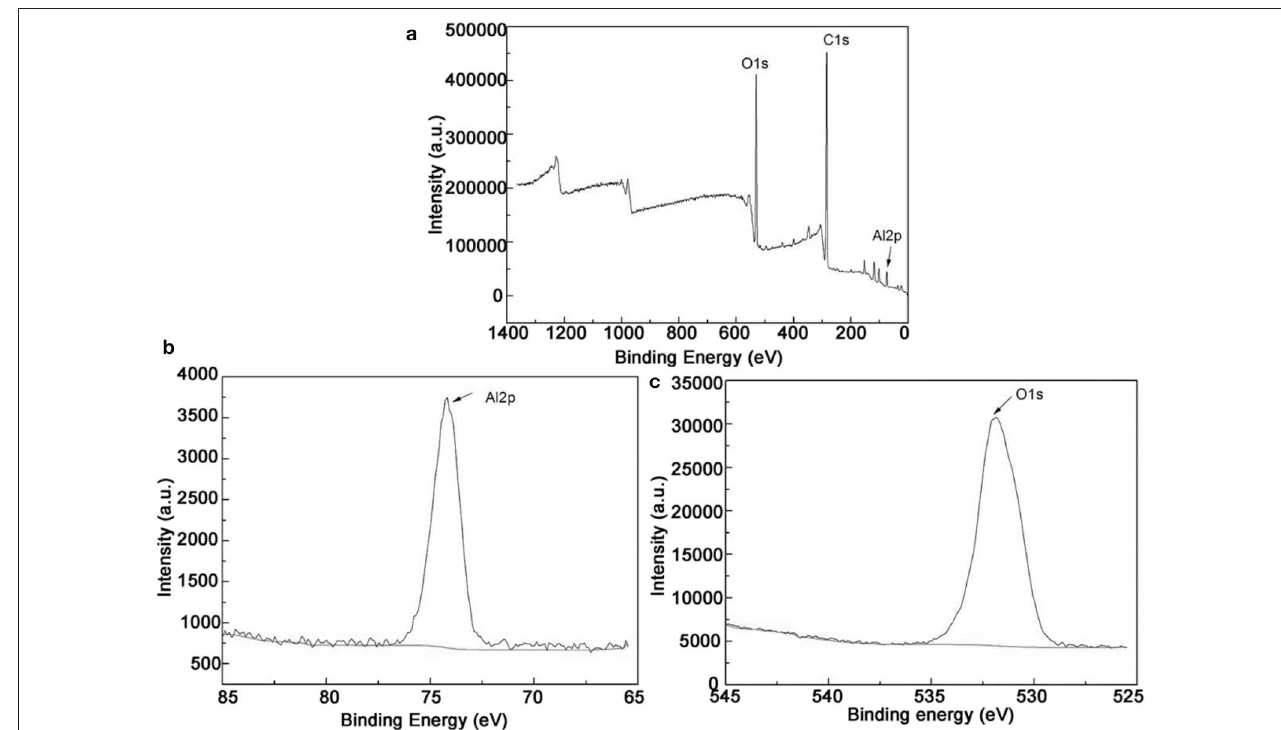
FIGURE 9 | (a) XPS for coating after oxidation 15h; (b,c) are the films deposited for Al 2p and O1s cores, respectively.